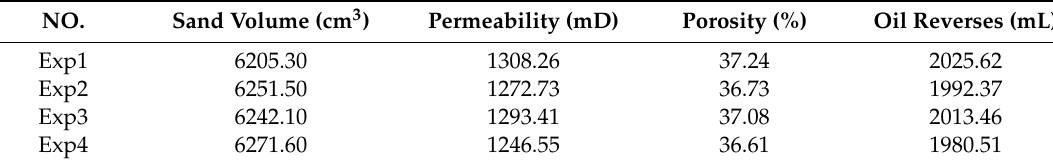
Table 4. Physical properties comparison of the sand pack models.